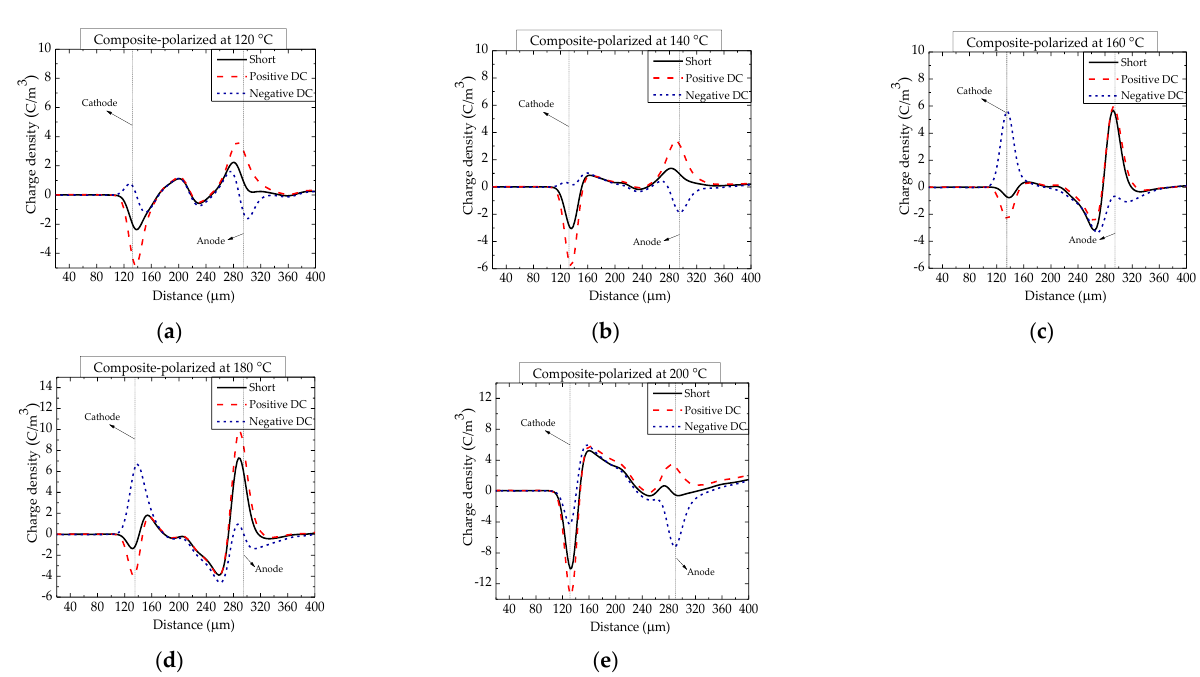
Figure 4. Space charge distribution in epoxy/nano − SiO 2 /micro − BN composite polarized at temper- atures between 40 and 100 °C. ( a ) 40 °C; ( b ) 60 °C; ( c ) 80 °C and ( d ) 100 °C.